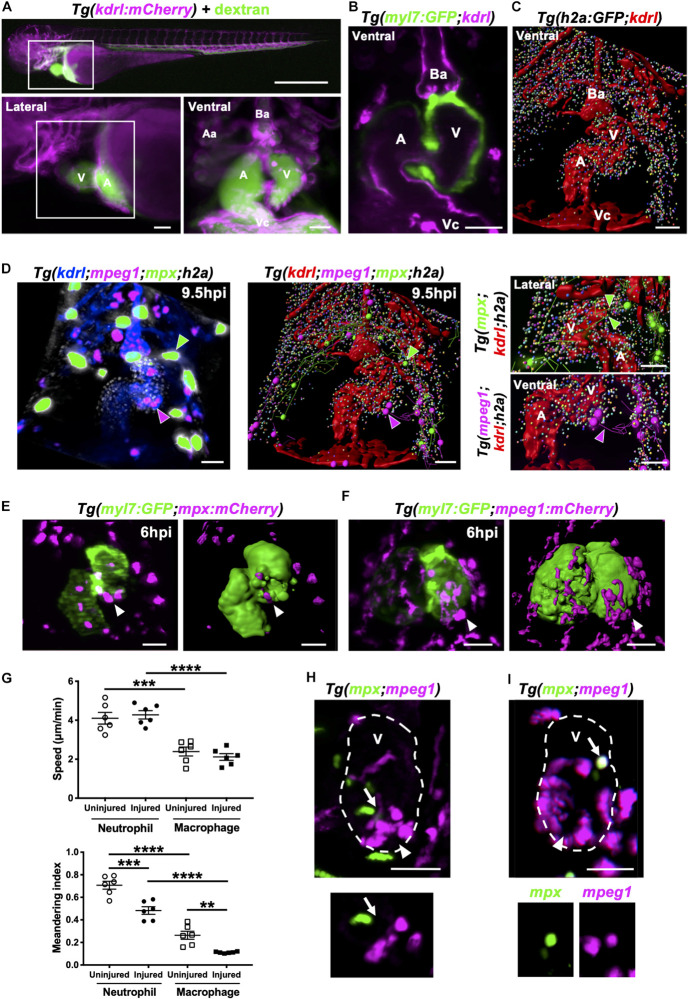
Neutrophils and macrophages migrate onto the ventricle via the pericardium and adopt specific migratory behaviors once on the ventricle following injury. (A) Epifluorescence image of Tg(kdrl:mCherry) larva injected with blue fluorescent 500 kDa dextran (colored green) to analyze the surrounding pericardium for vasculature (white box). Scale bar = 500 μm (top). Magnified epifluorescence image of the surrounding pericardium where white box indicates the nearby heart region (lower left). Magnified 3D LSFM image displaying the hearts vasculature (magenta) containing fluorescent dextran (green) (lower right). (B) LSFM z-plane of Tg(myl7:GFP;kdrl:mCherry) larva displaying the hearts myocardium and endothelium. (C) Surface rendered LSFM z-stack of Tg(h2a:GFP;kdrl:mCherry) larva displaying the hearts vasculature and surrounding pericardium. (D) LSFM fluorescence z-stack differentially color-labeled (left) and surface rendered z-stack (middle and right) of Tg(kdrl:mCherry;mpeg1:mCherry;mpx:GFP;h2a:GFP) larva displaying the heart vasculature (blue or red), pericardium (gray or multi-colored), neutrophils (green) and macrophages (magenta) at 9.5 hpi. Magnified view of neutrophil (right top) and macrophage (right bottom) tracks onto the ventricle. Green and magenta arrowheads indicate neutrophils and macrophages tracked to the ventricle respectively for 30 min from 9.5 hpi. (E) LSFM image (left) and surface render (right) of a Tg(myl7:GFP;mpx:mCherry) injured heart and recruited neutrophils at 6 hpi. (F) LSFM image (left) and surface render (right) of a Tg(myl7:GFP;mpeg1:mCherry) injured heart and recruited macrophages at 6 hpi. White arrowheads indicate recruited immune cells on the lesioned myocardium. (G) Ventricular recruited neutrophil and macrophage speed (top) and meandering index (distance traveled/displacement) (bottom) in heart lasered and uninjured larvae. Average cell behaviors are plotted per larva, n = 5 cells tracked per larva and n = 6 larvae per group. Error bars, SEM. One-way ANOVA and Tukey post hoc test performed for comparisons between mean behavioral values for each larva where ** p < 0.01, *** p < 0.001, and ****p < 0.0001. (H) LSFM image of a Tg(mpx:GFP;mpeg1:mCherry) injured ventricle displaying neutrophils and macrophages at 10 hpi. Arrow indicates a neutrophil and macrophage near the wound (top). LSFM z-plane image of the indicated neutrophil and macrophage. Arrow indicated at the same position (bottom). (I) LSFM image of a Tg(mpx:GFP;mpeg1:mCherry) injured ventricle displaying neutrophils and macrophages at 18 hpi. Arrow indicates a cell co-expressing mpx:GFP and mpeg:mCherry on the wounded ventricle (top and bottom). Arrowheads indicate the injury site. Outline of ventricle is indicated with a dashed line. All fluorescence images were acquired in 3D using LSFM and displayed as MIPs unless stated otherwise. All scale bar = 50 μm, unless stated otherwise. Ba, bulbus arteriosus; Aa, aortic arches; V, ventricle; A, atrium; Vc, venous cavernous.